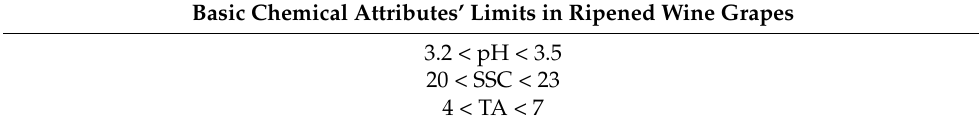
Table 2. SSC, pH, and TA indicative limits in ripened grapes.